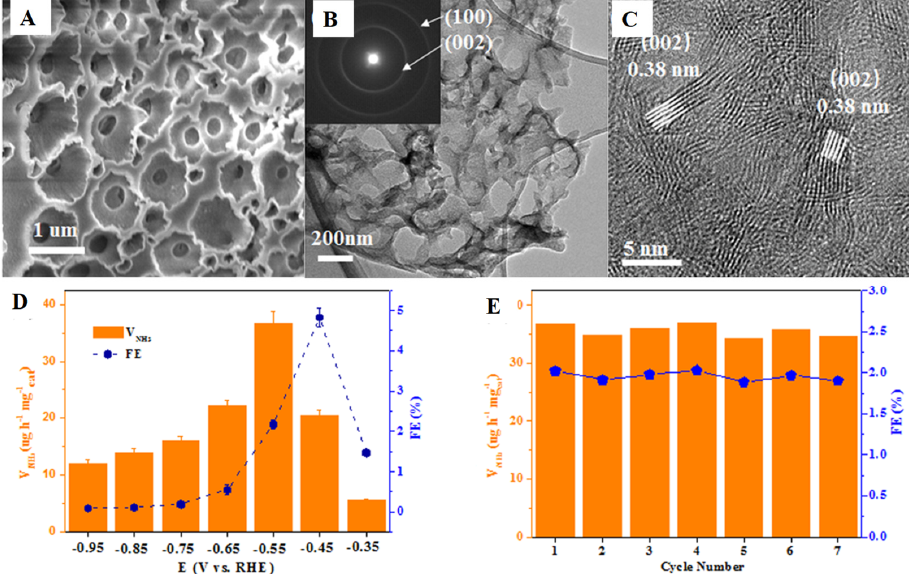
Figure 7. SEM, TEM, and HRTEM images of C ‐ BN are shown in ( A – C ), respectively. ( D ) FEs and VNH 3 and for C ‐ BN/CP at given potential. ( E ) Recycle test of C ‐ BN/CP at − 0.5 Volt